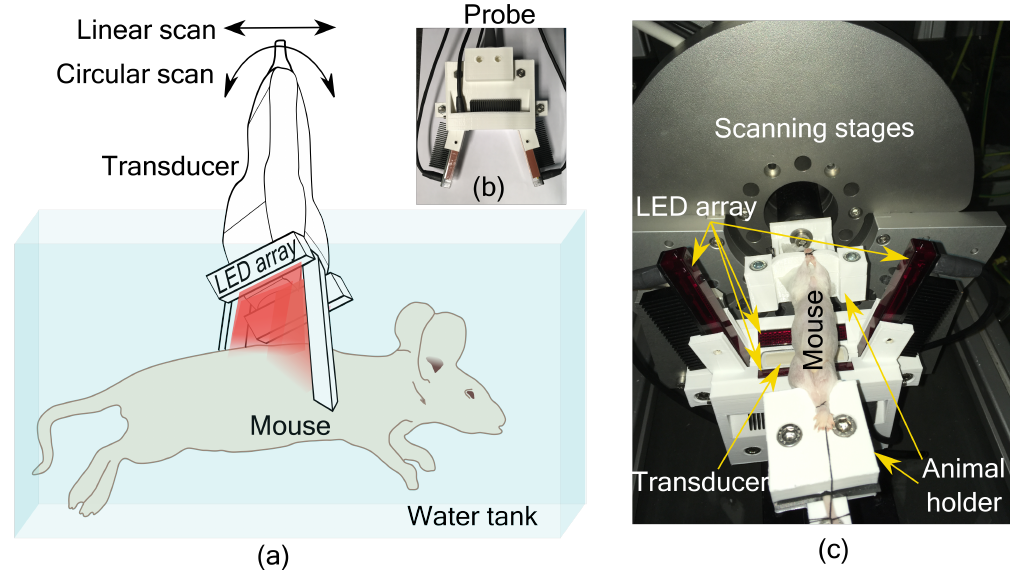
Figure 1. Small animal tomographic imaging system. ( a ) Schematic of the set-up with the imaging probe scanning around the mouse in a water tank. ( b ) Imaging probe with linear transducer array and four LED arrays in a 3D printed holder. ( c ) Photograph of the imaging set-up showing mouse holder, imaging probe and the scanning